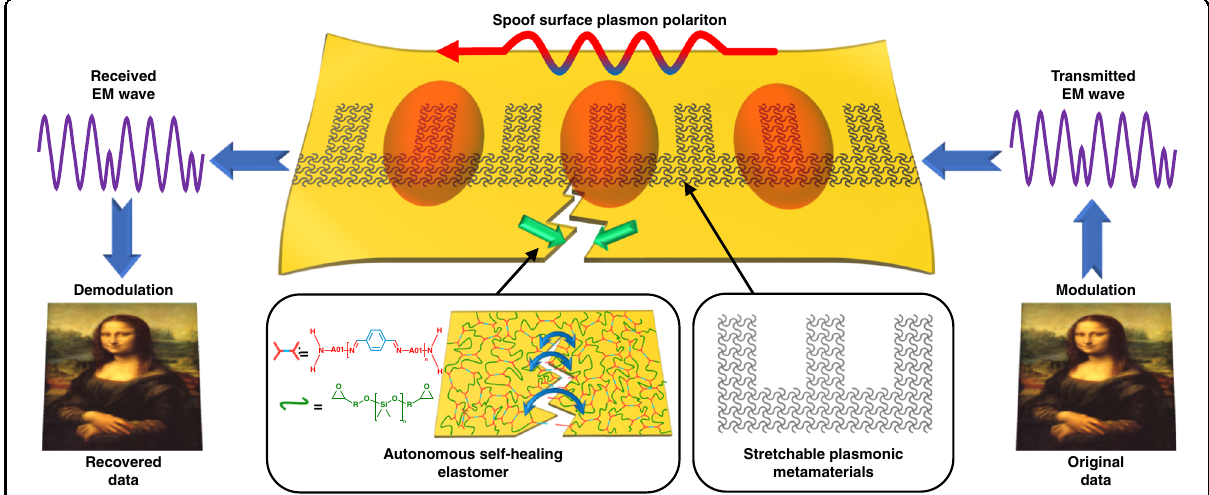
Fig. 1 Conceptual illustration of the stretchable and self-healable spoof plasmonic meta-waveguide. Self-healing material enhances structural strength and durability, while the SSPP structure improves reliability and gives more tolerance to the self-healing